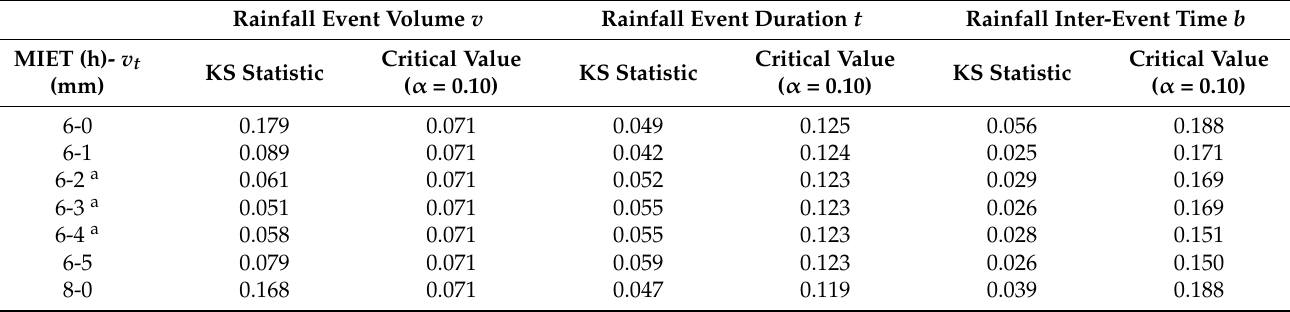
Table 6. Results of K-S tests for